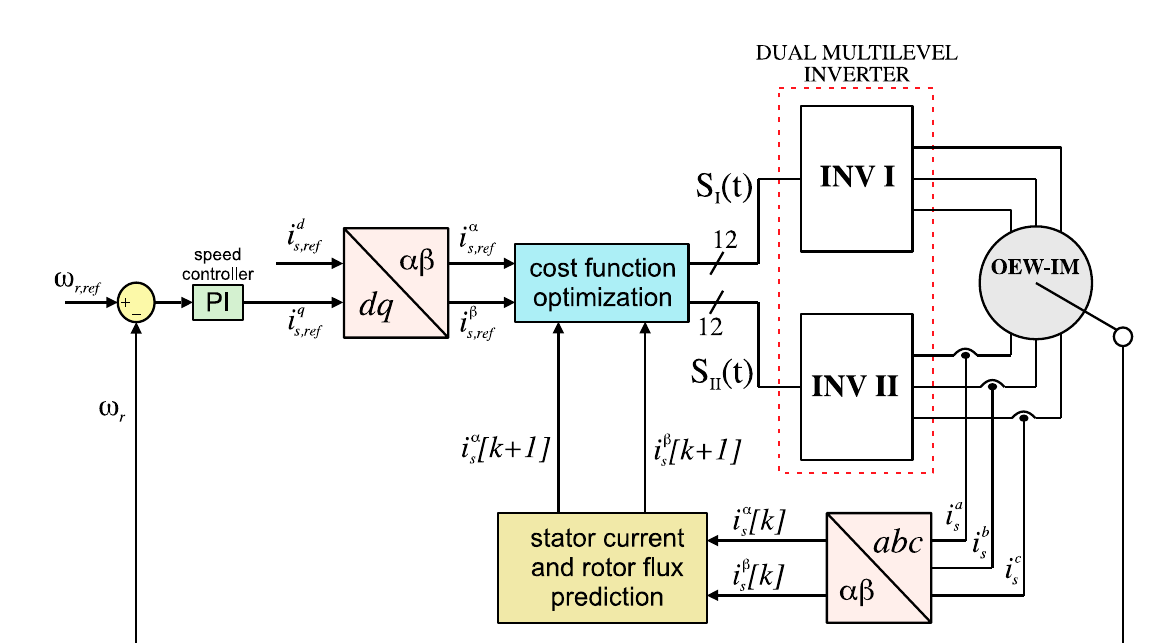
Figure 3. Diagram of the proposed current predictive control strategy for an open-end winding machine drive.